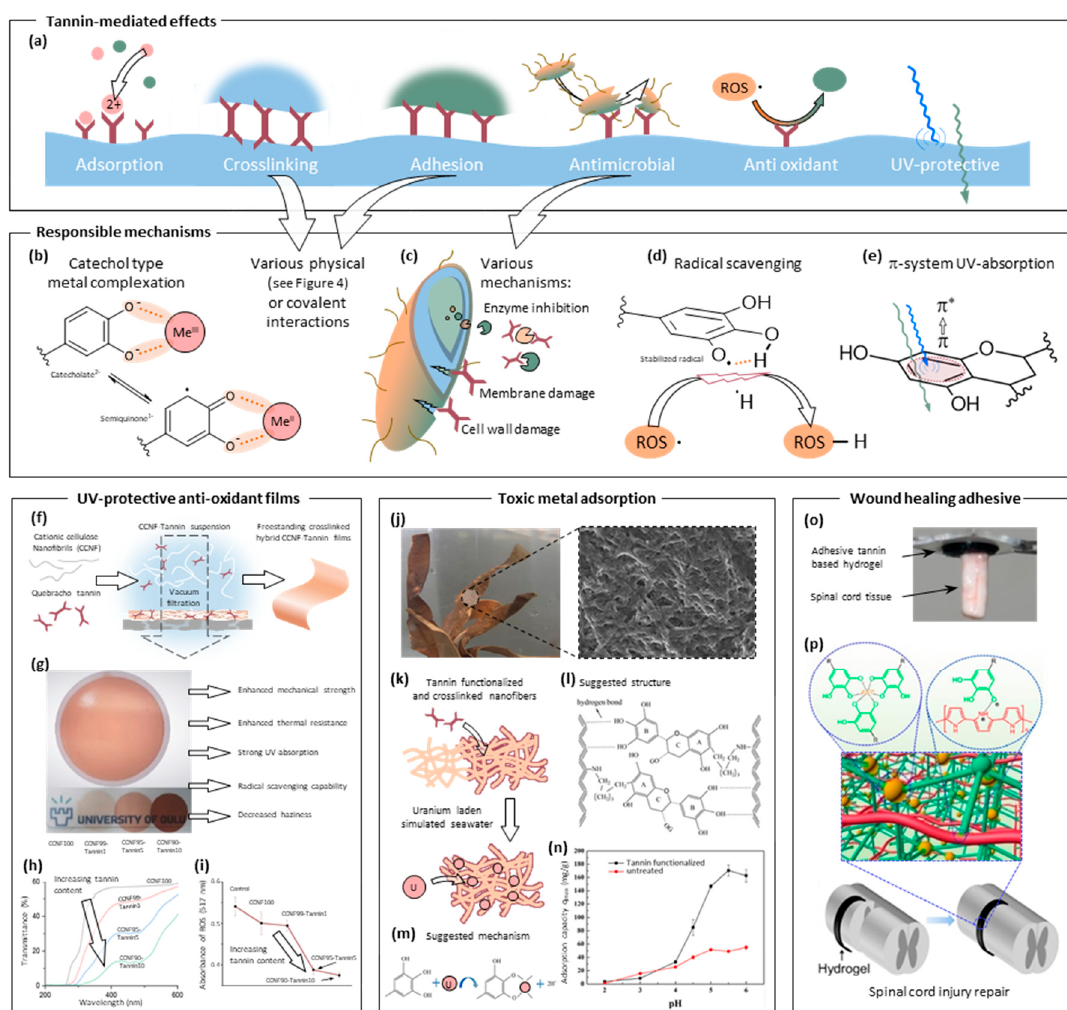
Figure 5. ( a ) Schematic representation of various possible functionalities accessible with tannin-based hybrid materials. ( b – e ) General schematic representations and mechanisms of valence tautomerism between the catecholate-metal(III) and semiquinone-metal(II) isomers ( b ); several known points of antimicrobial action of tannins ( c ); reactive oxygen species (ROS) scavenging mediated by phenolic homolysis ( d ); and UV-shielding by absorption due to π – π ∗ transitions of the phenolic aromatic rings ( e ). ( f – i ) Schematic representation of fabrication ( f ); optical appearance and key features ( g ); UV–Vis spectra ( h ); and ROS scavenging ability ( i ) of cellulose–tannin films. Adapted with permission from [109]. Copyright 2019 Elsevier Inc. ( j – n ) Optical appearance and microstructure ( j ) and schematic representation ( k ) of gelatin nanofiber–tannin based adsorbent material tested with Uranium ions ( k ) with suggested chemical structure ( l ) as well as the complexation mechanism ( m ) and the resultant adsorption isotherms ( n ). Adapted from with permission [132]. Copyright 2018 Elsevier Inc. ( o , p ) Adhesive polypyrrole–tannin–Fe(III)-based hydrogel for spinal cord injury wound healing applications with high conductivity and cytocompatibility. Adapted with permission from [133].